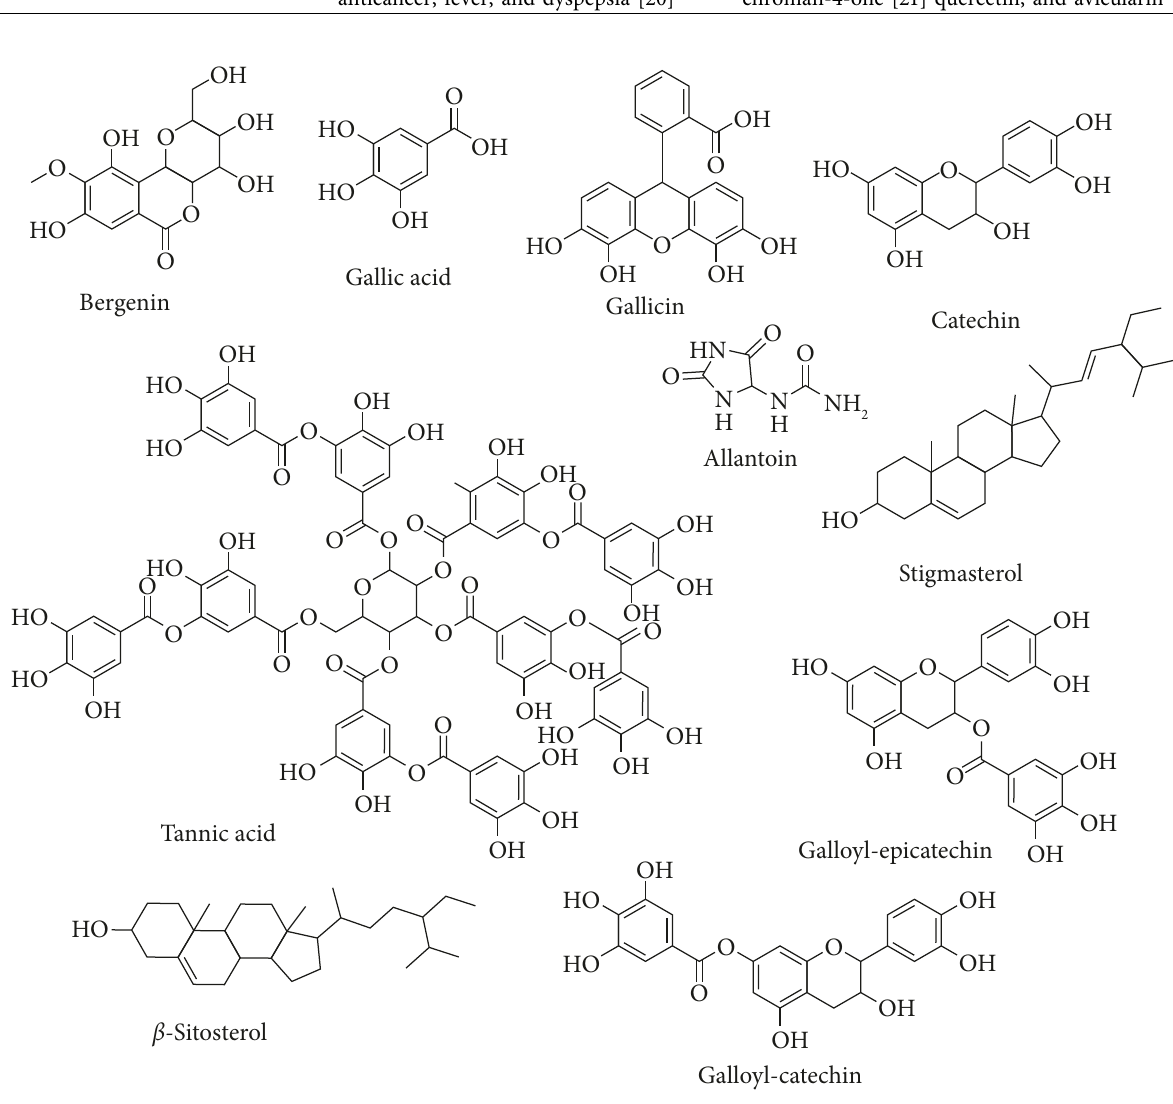
Figure 1: Structure of plant secondary metabolits from B . ciliata